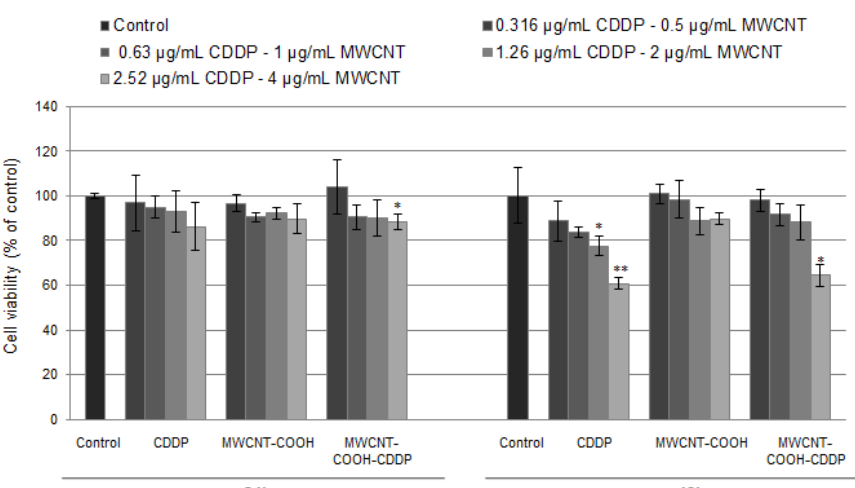
Figure 5. MDA-MB-231 breast cancer cell viability after 24 and 48 h of exposure to various concentrations of MWCNTs (0.5–4 µg/mL) and CDDP (0.316–2.52 µg/mL). The results are calculated as the mean ± SD of 3 replicates and represented relative to control (untreated cells—100% cellular viability). * p < 0.05, ** p < 0.01 vs. control.